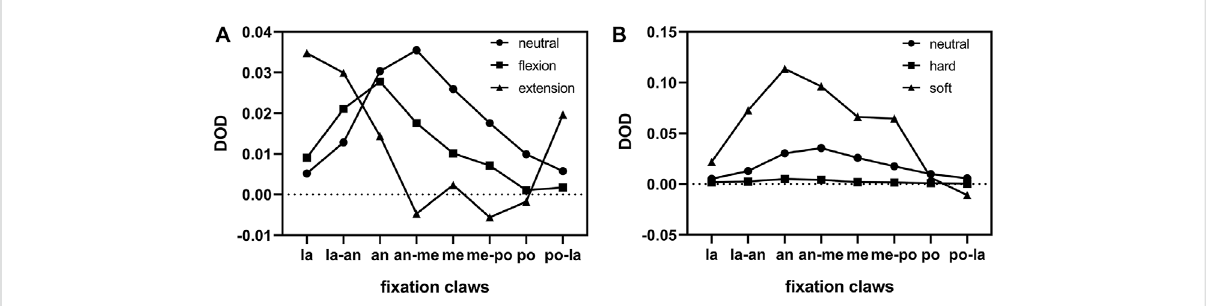
FIGURE 7 DistributionofDODfordifferent fi xationclaws. (A) ,Comparisonofdifferenthumeralpostures. (B) ,Comparisonofdifferentlinerstiffnesses.la= lateral, an = anterior, me = medial, po =